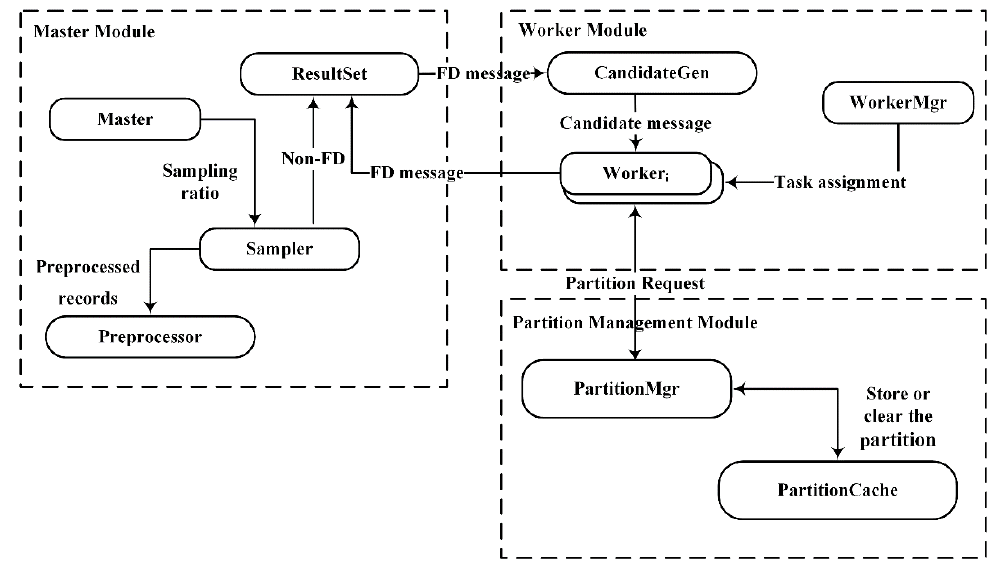
Figure 2. DisTFD logical structure diagram.